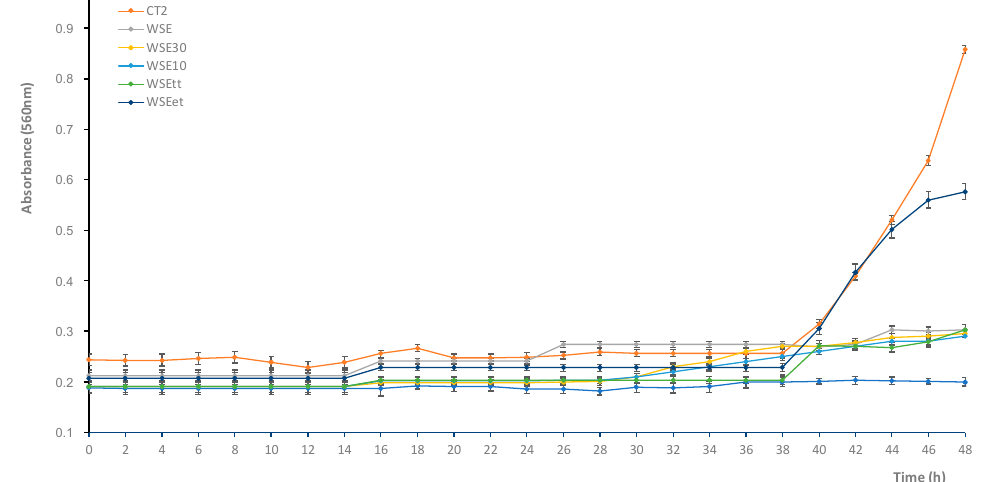
Figure 2. Inhibitory activity of the water/salt-soluble extract (WSE) obtained from chickpea sourdough fermented at 30 °C for 24 h with Lactoplantibacillus plantarum LB1 and Furfurilactobacillus rossiae LB5. CT1, non-inoculated Malt Extract Broth (MEB) added with 30% ( v/v ) of sterile water; CT2, MEB inoculated with 10 4 conidia/mL and added with 30% ( v/v ) of sterile water; WSE30 and WSE10: MEB inoculated with 10 4 conidia/mL and added with 30% ( v/v ) of the ultra-filtration permeates obtained at the cut-off of 30 and 10 KDa, respectively; WSEet and WSEtt: MEB inoculated with 10 4 conidia/mL and added with 30% ( v/v ) of the WSE subjected to enzymatic or thermal treatment, respectively. Incubation was carried out at 25 °C.